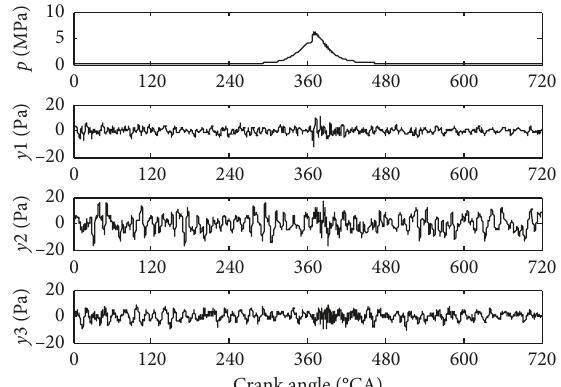
Figure 11: Cylinder pressure signal and each side noise signals of a working cycle of the internal combustion